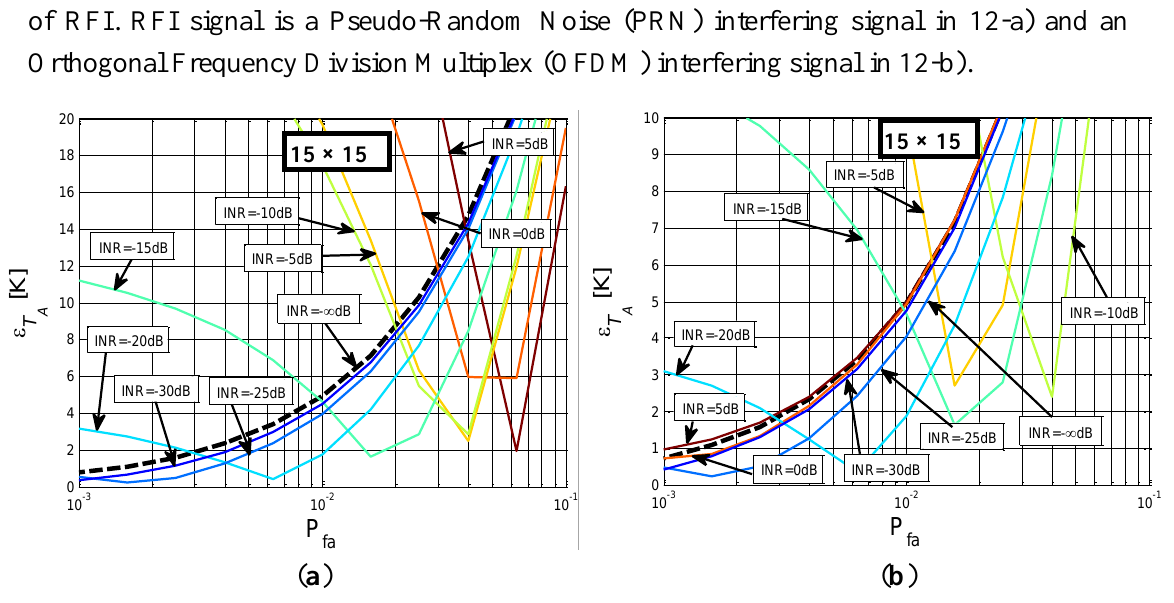
using a 15 × 15 A